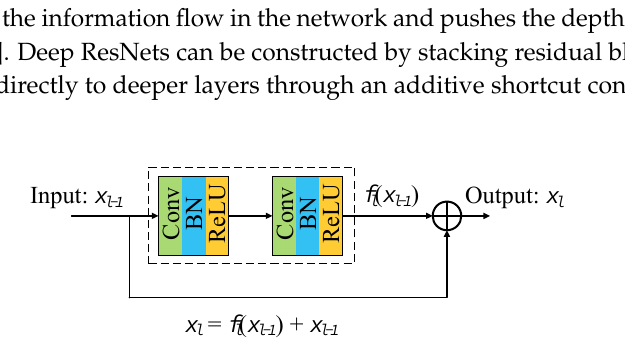
Figure 1. Typical residual block architecture.